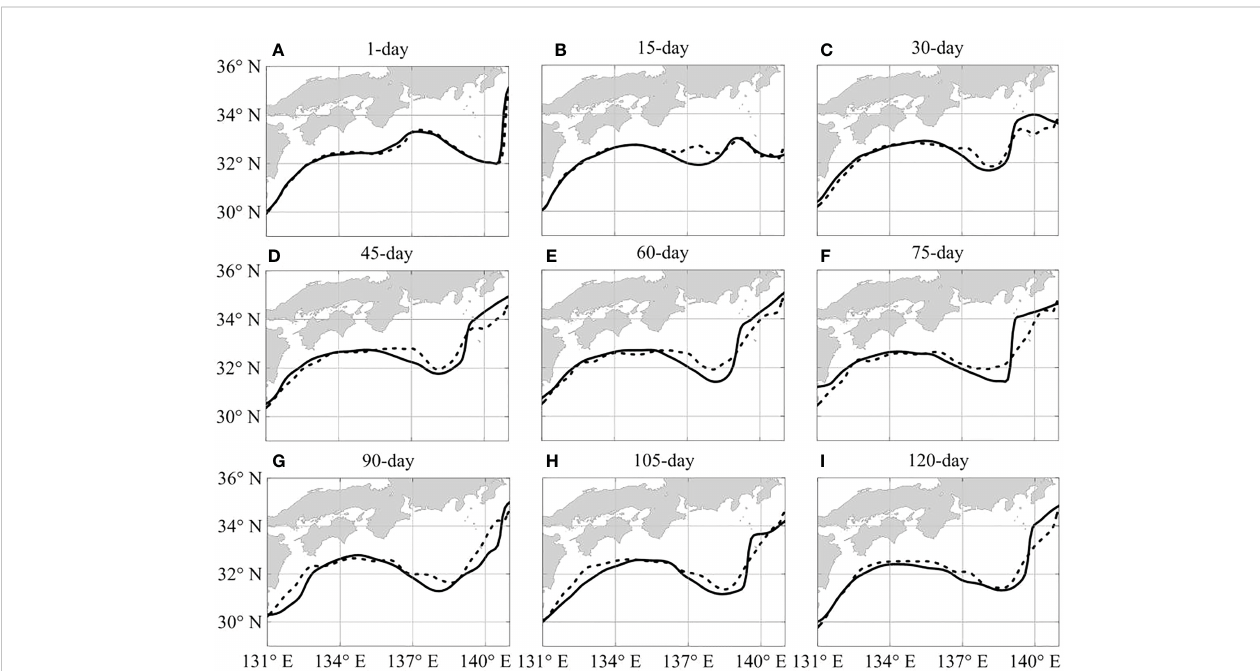
FIGURE 7 Prediction results of the Kuroshio path with the lead time of 120 days from July 1 (1-day) to October 28 (120-day), 2017 (A – I) . The solid curve represents the true path, and the dashed one represents the